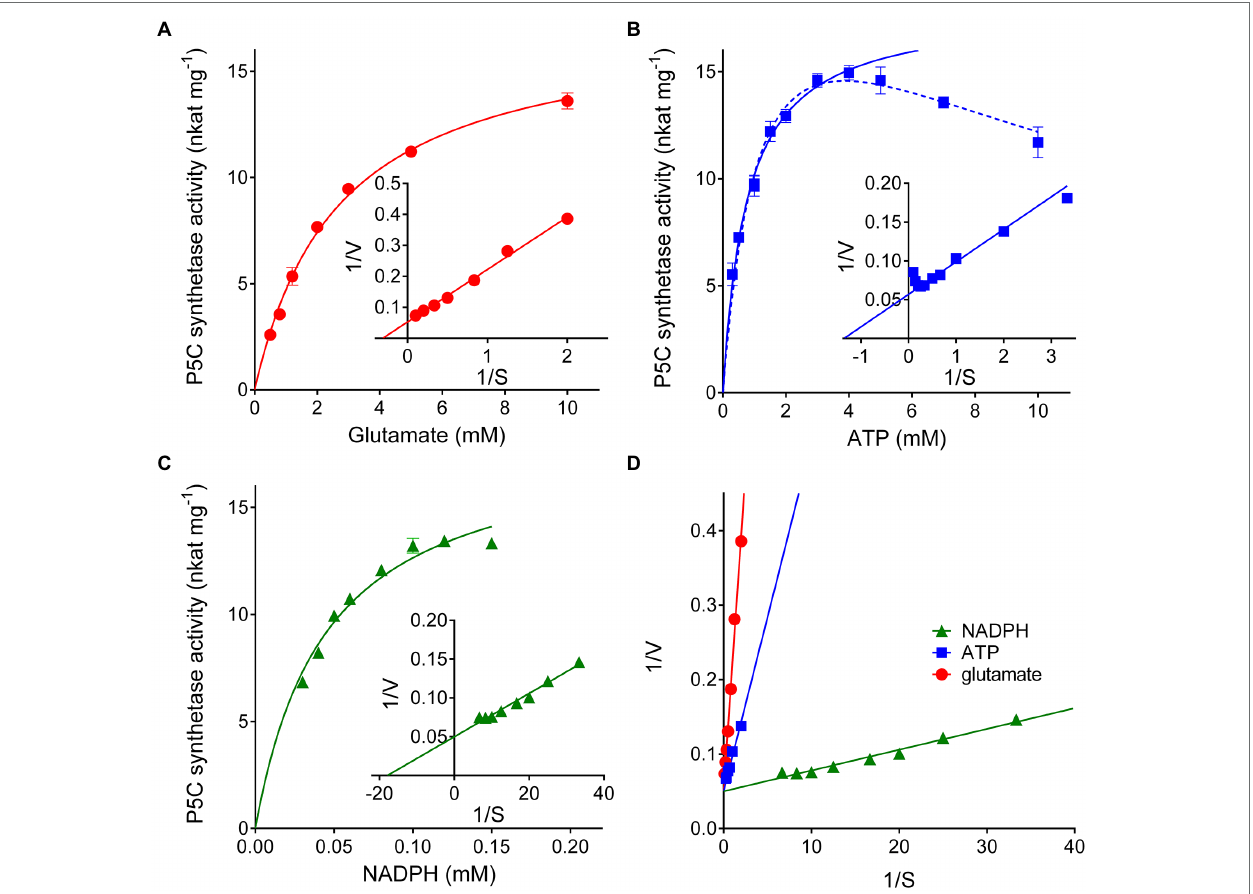
FIGURE 3 | Substrate affinity and catalytic properties of rice P5C synthetase 2. Enzyme activity was measured by the NADPH oxidation assay at varying the concentration of glutamate (A) , ATP (B) , or NADPH (C) while maintaining the fixed concentrations of the other substrates (20 mM glutamate, 4 mM ATP, and 0.4 mM NADPH). Lineweaver-Burk plots of data (the inset in each panel) allowed calculation of apparent affinities and V max values ( Table 1 ). Presented results are means ± SE over three technical replicates. The experiments were repeated three times with different enzyme preparations, obtaining very similar values. In panel (B) , the solid line refers to non-linear interpolation obtained by considering ATP concentrations up to 4 mM, whereas the dashed line is that obtained by considering all the experimental values using a substrate inhibition model. To gain information on the reaction mechanism of this multisubstrate enzyme, a combined Lineweaver-Burk graph was plotted (D) .